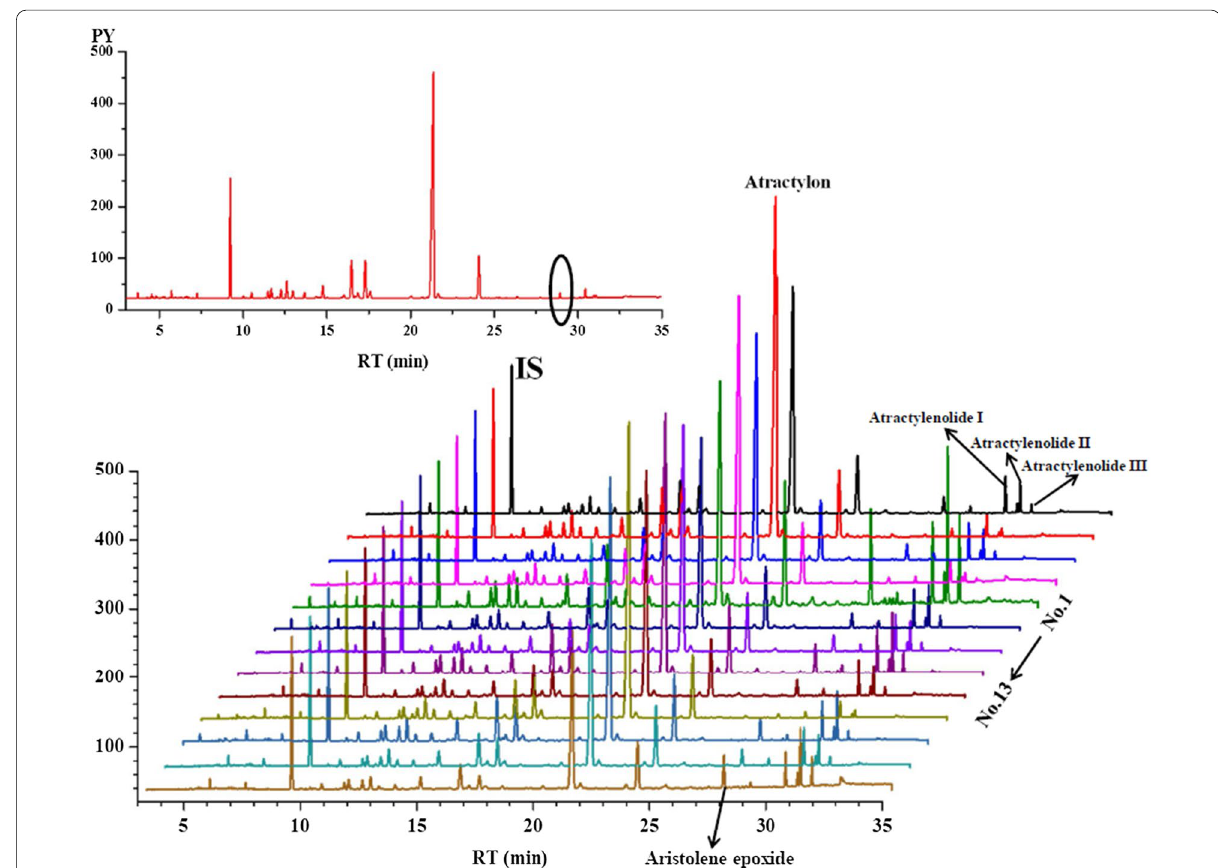
Fig. 4 GC-FID chromatograms of A. rhizoma essential oil before and after storage at different temperature and humidity